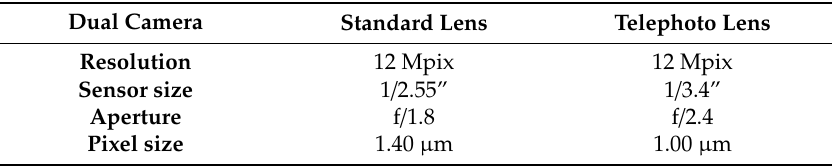
Table 2. Xiaomi Mi2 camera